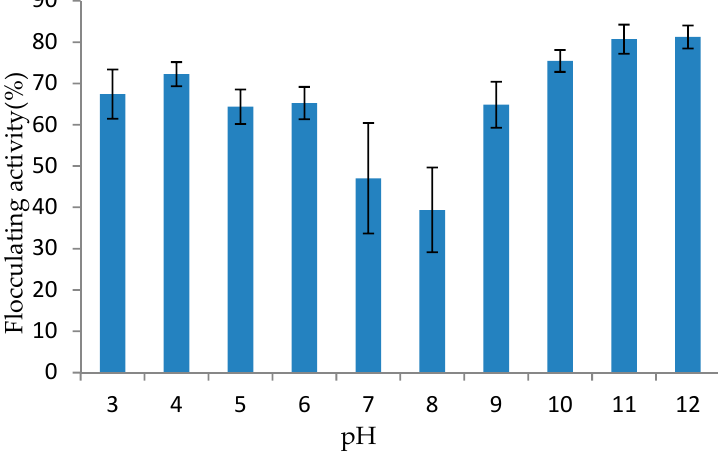
Figure 4. Effect of pH on Flocculating Activity of Bioflocculant Produced by the Tested Strain ( Bacillus sp.).